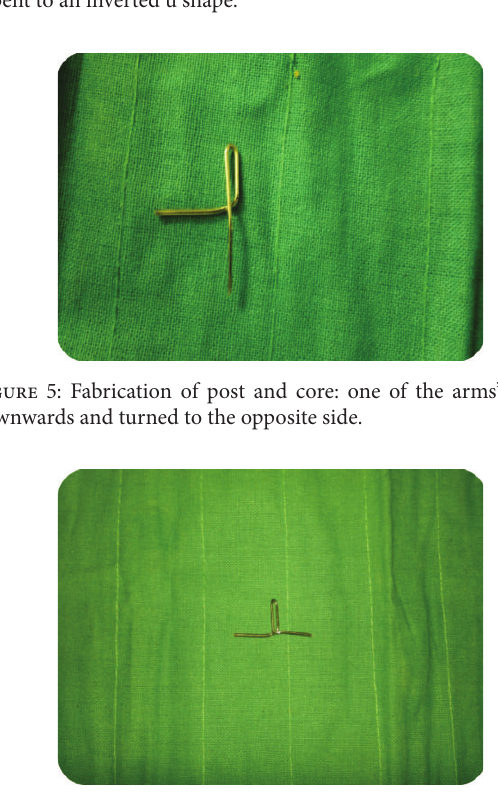
Figure 4: Fabrication of post and core step 1: 1.5 inch 19 gauge wire is bent to an inverted u shape.